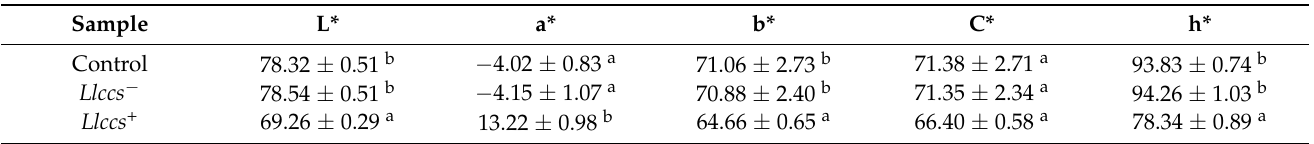
Table 5. Chromaticity changes in the downward directed petal of control, Llccs − and Llccs + transgenic greenhouse-grown V. cornuta plants expressed by CIE L*a*b* system.